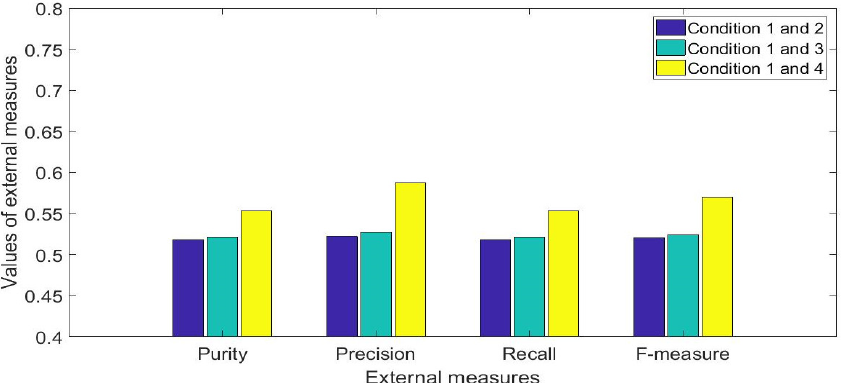
Figure 9. Results of the median values of external measures for the combination of the ML and AP directions for 30 repetitions. directions for 30